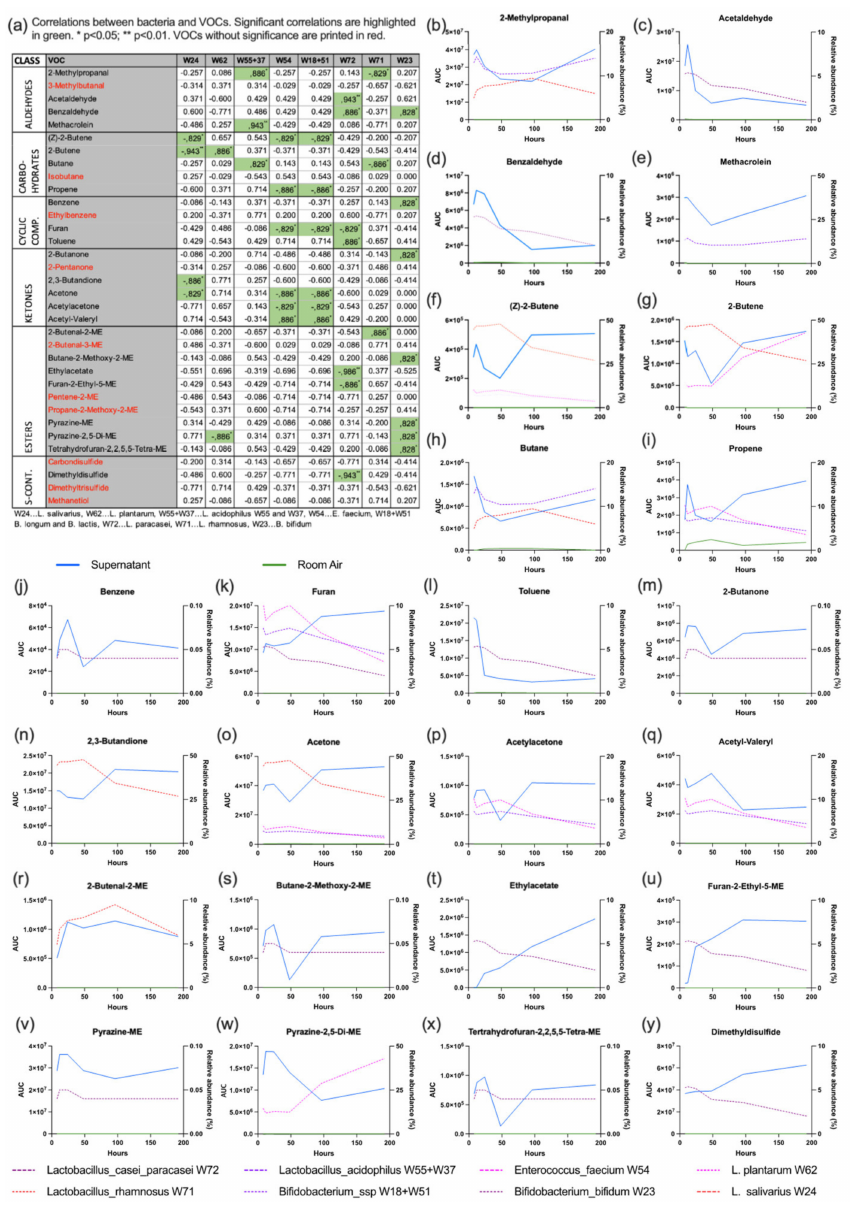
Figure 4. VOC analysis. The table ( a ) gives an overview of all VOCs and their correlation with the relative abundance of probiotic bacteria. The graphs ( b – y ) show the profile of the VOC (blue solid line), the room air (green solid line) and the relative abundance of the correlating probiotic bacterium (dashed